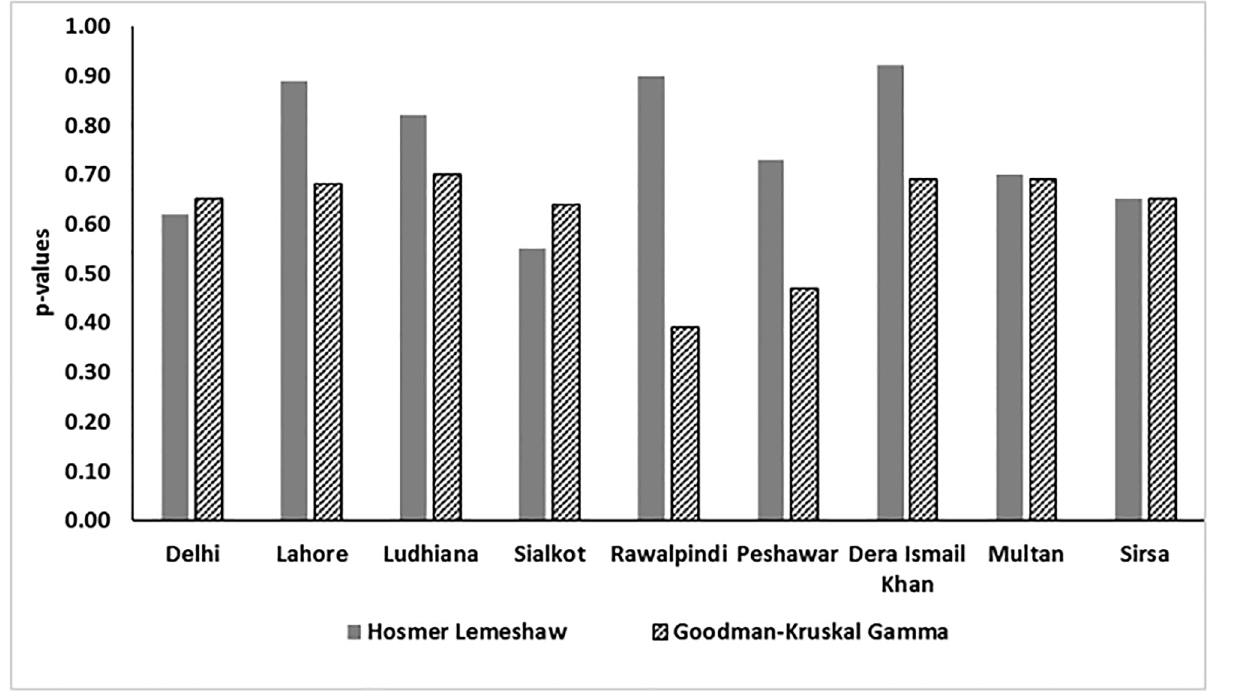
Fig 7. Statistical metrics for measure of association of cholera with air temperature and precipitation in the Indus River Basin. (Somers ’ D and Goodman Kruskal Gamma p-values were multiplied with 100 for comparison